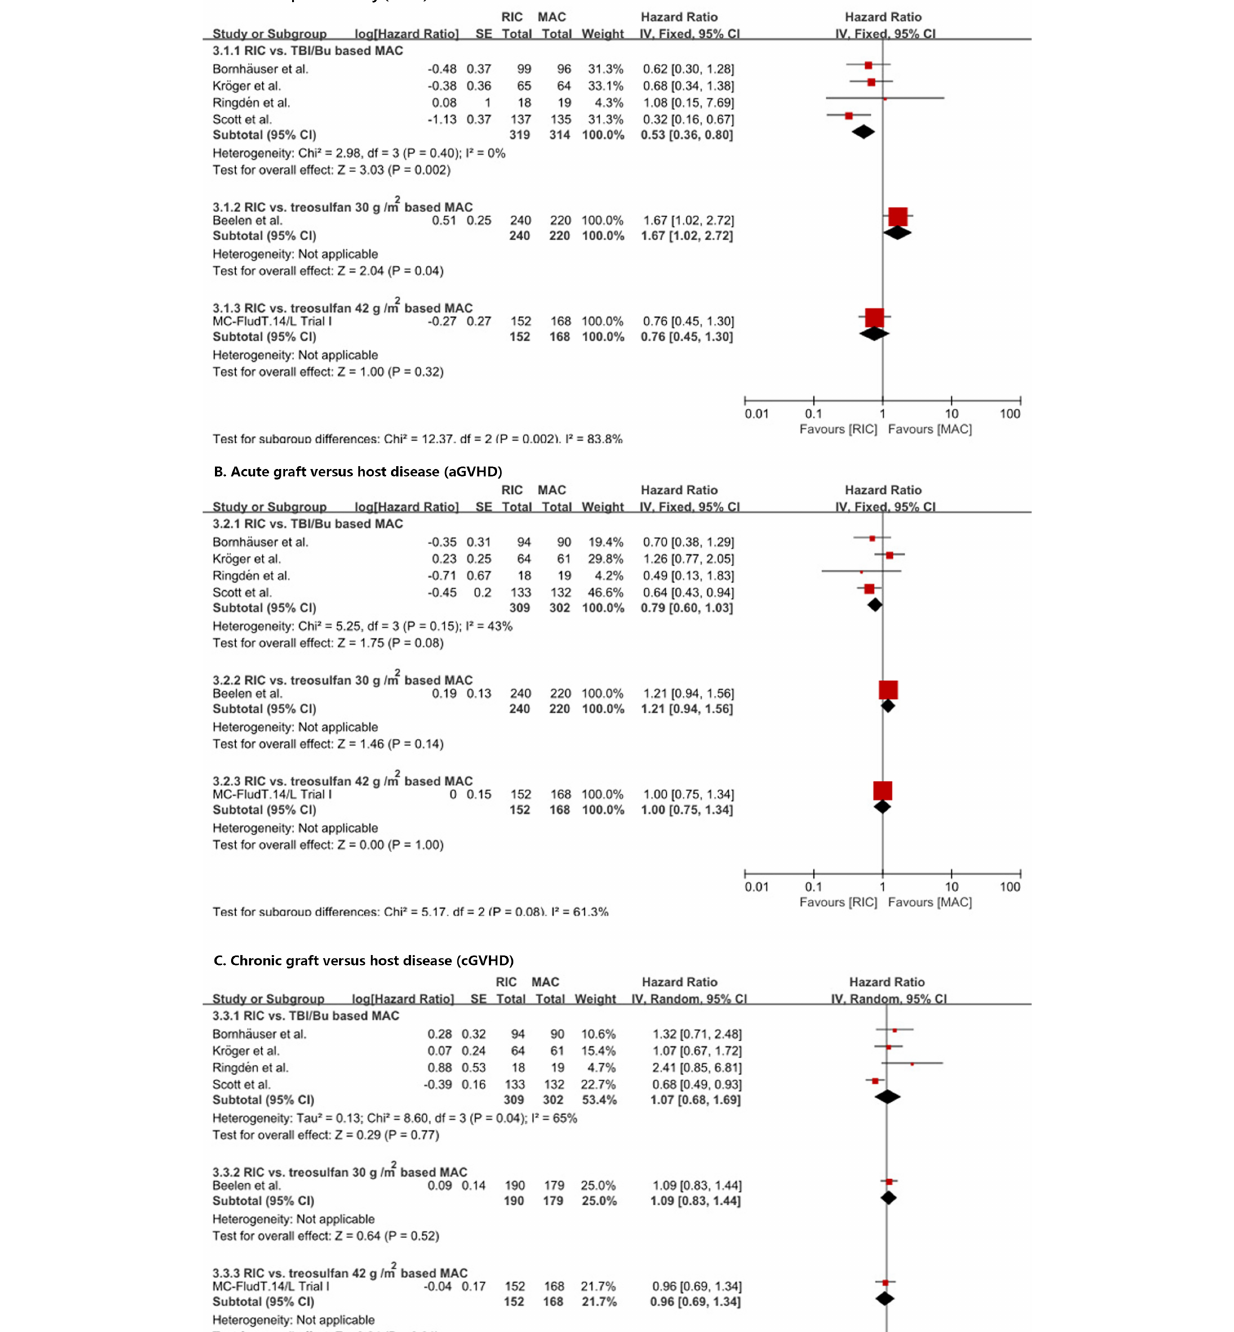
Frontiers in Oncology |